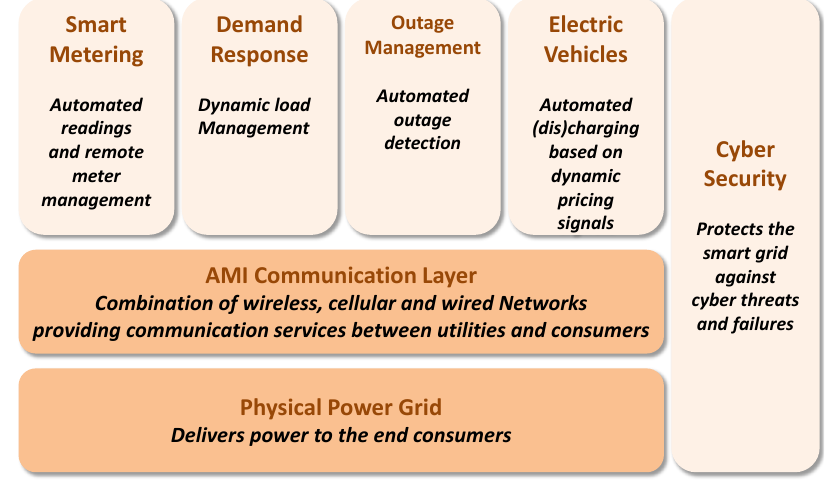
Figure 1. A functional view of the smart grid layers (AMI: advanced metering